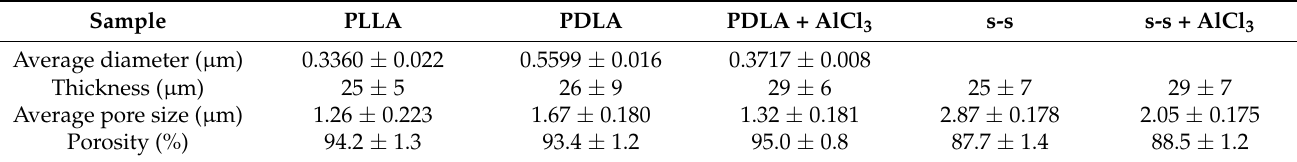
Table 2. The average diameter, thickness, average pore size and porosity data of five fiber membrane samples. Sample PLLA PDLA PDLA + AlCl 3 Average diameter ( µ m) Average pore size ( µ